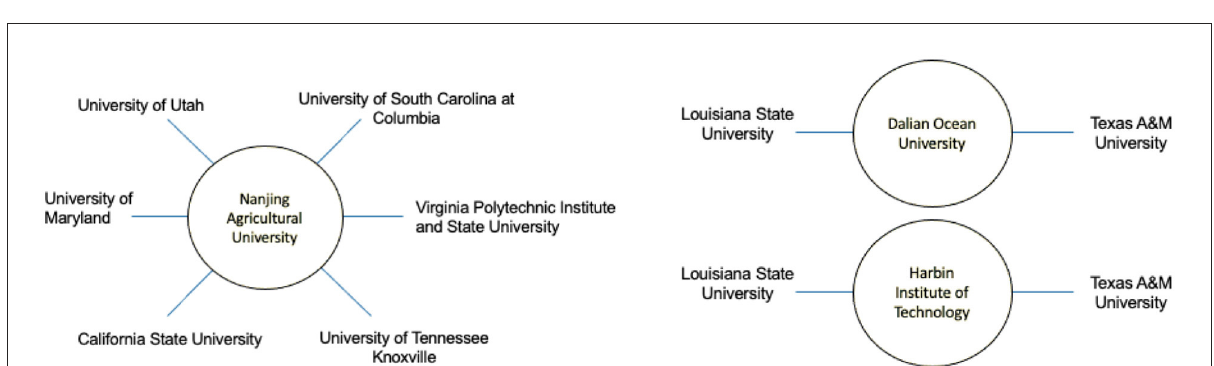
FIGURE1 InFEWS US-China collaboration networks of selected Chinese universities.